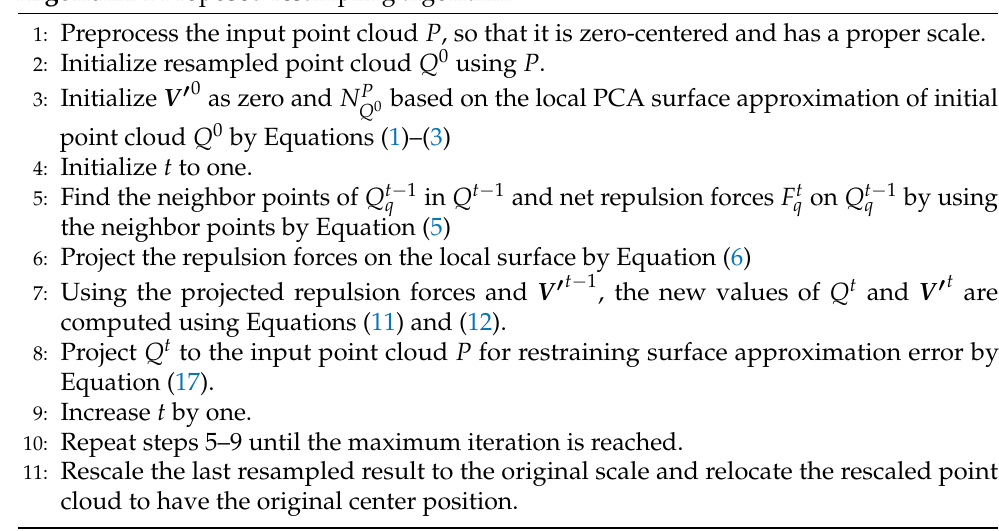
Algorithm 1 Proposed resampling